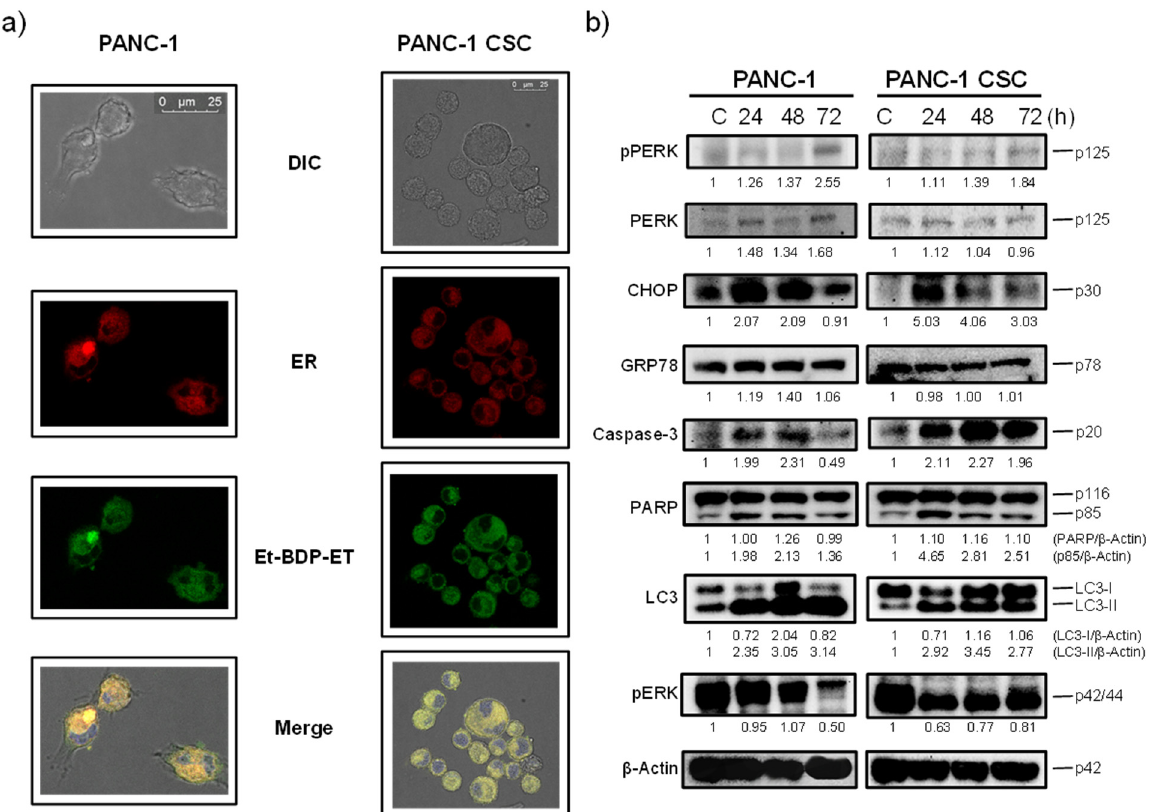
Figure 5. Subcellular localization of edelfosine in the ER of PANC-1 cells and PANC-1 CSC pancreatic cancer spheroids, and induction of an ER stress response. ( a ) Live PANC-1 cells and PANC-1 CSC pancreatic cancer spheroids were labeled overnight at 37 °C for the ER in red using the CellLight ER-RFP BacMam 2.0 reagent, and then the samples were incubated with 20 μ M Et-BDP-ET (green fluorescence) for 3 h at 37 °C. Areas of colocalization between the ER and Et-BDP-ET in the merge panels are yellow. The cells were also stained for nuclei with DAPI (blue fluorescence). The corresponding differential interference contrast (DIC) microscopy images are also shown. Bar, 25 μ m. The data are representative of three independent experiments. ( b ) PANC-1 cells and PANC-1 CSCs were untreated (C) or treated with 20 μ M edelfosine for the indicated times and analyzed by means of Western blotting using specific antibodies for the denoted proteins; β -actin was used as the loading control. Molecular weights (in kilodaltons) of every protein are indicated at the right side of each panel. The gels were cropped to show the relevant sections. Relative protein level quantification after normalization to the internal control β -actin is included below each Western blot panel. The Western blot images are representative of three independent experiments.